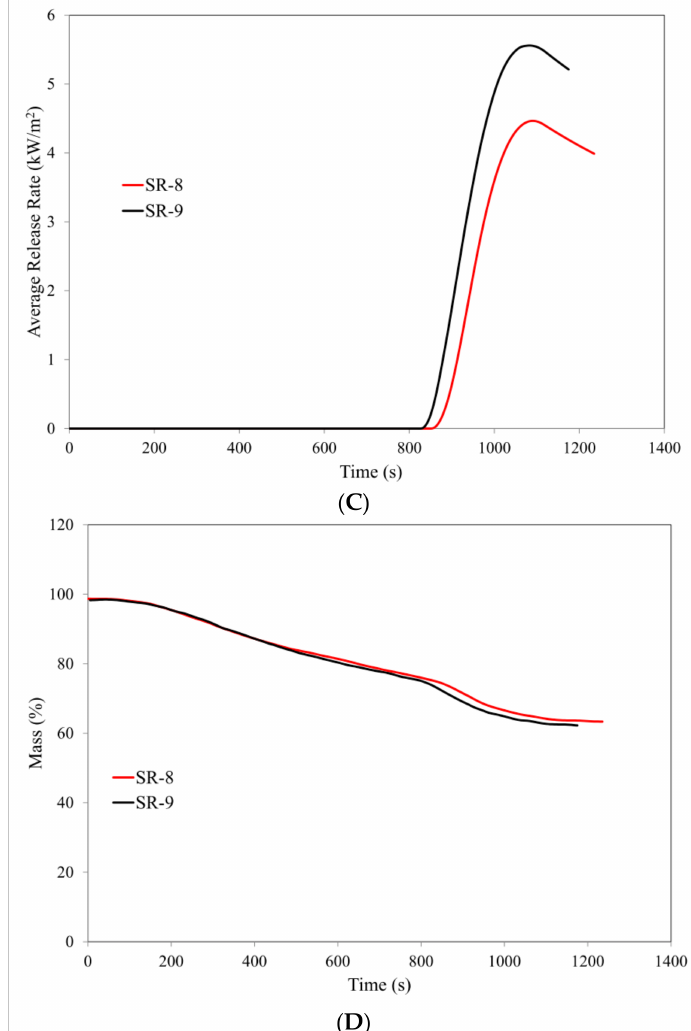
Figure 11. Cone calorimetry analysis: ( A ) max heat release rate, ( B ) total heat released, ( C ) average release rate (ARHE), ( D ) mass